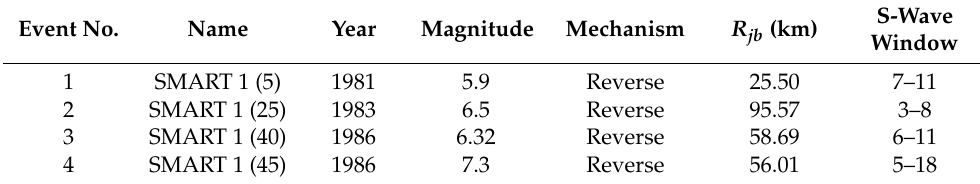
Table 1. Metadata of